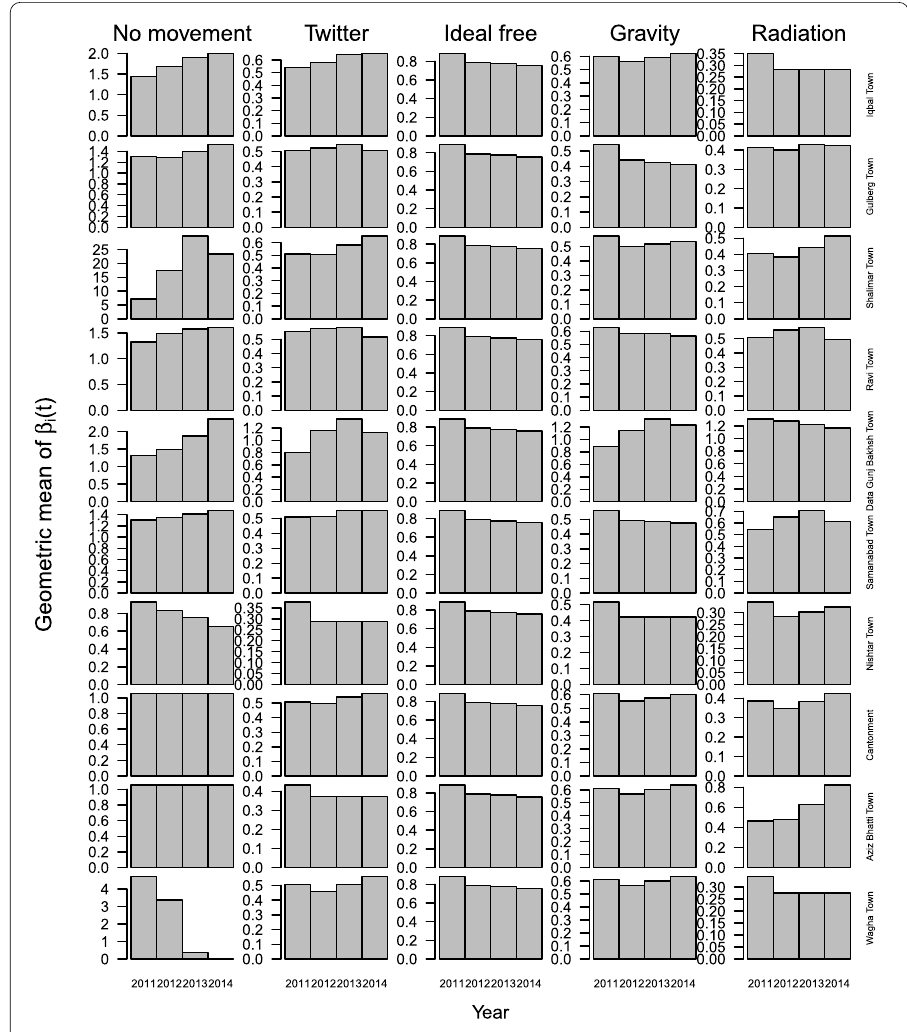
Figure 8 Geometric means of β i ( t ) stratified by year (x-axis), town (rows), and mobility assumption